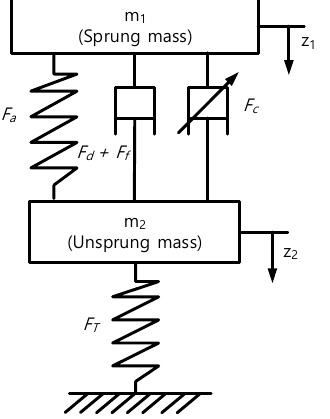
Figure 2. Modeling the landing gear equipped with the MR damper.